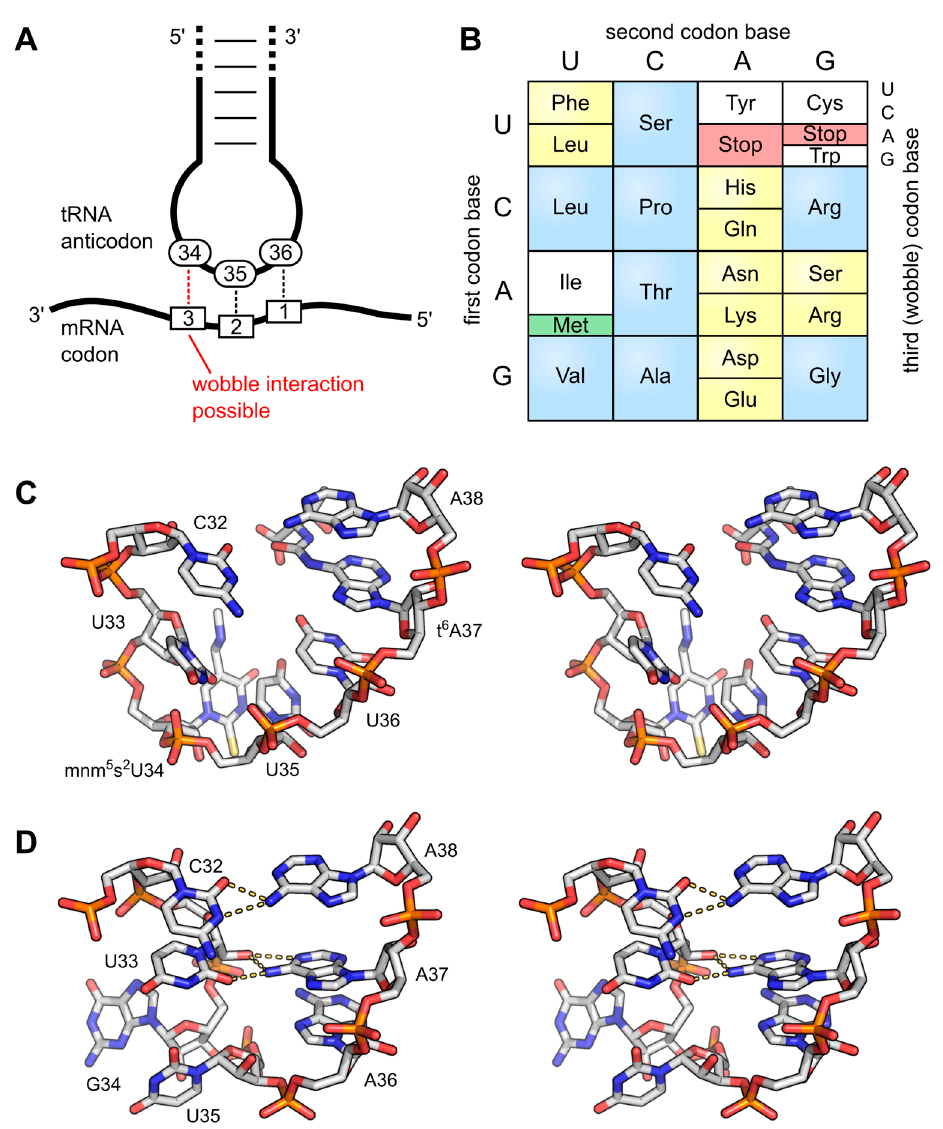
Figure 5. Modifications in decoding and anticodon loop structure. ( A ) The interaction of the anticodon bases (34–36) of a tRNA with the corresponding bases of the mRNA codons (3, 2, 1). A wobble interaction is possible between codon base 3 and anticodon base 34. The latter is frequently modified and directs the wobble interactions with the third codon base; ( B ) The standard genetic code is illustrated as a simple decoding table, 2-fold degenerate codon boxes are colored yellow, 4-fold degenerate boxes are blue. Start and stop codons are colored green and red, respectively; ( C ) Stereo image of the well-structured anticodon loop of tRNA Lys from E. coli . Modifications mnm 5 s 2 U34 and t 6 A37 prevent wrong base pairing inside the 7-nucleotide loop and promote the formation of the conserved U-turn motif. The stacked anticodon bases are located on the same side of the loop. PDB: 1FL8 [91]; ( D ) Stereo image of a collapsed and unmodified anticodon loop of tRNA Tyr from Bacillus subtilis . Here, bases 32 and 38 as well as 33 and 37 interact with each other and the U-turn motif is missing. The anticodon bases are not ordered and on opposite sides of the loop. PDB: 2LAC